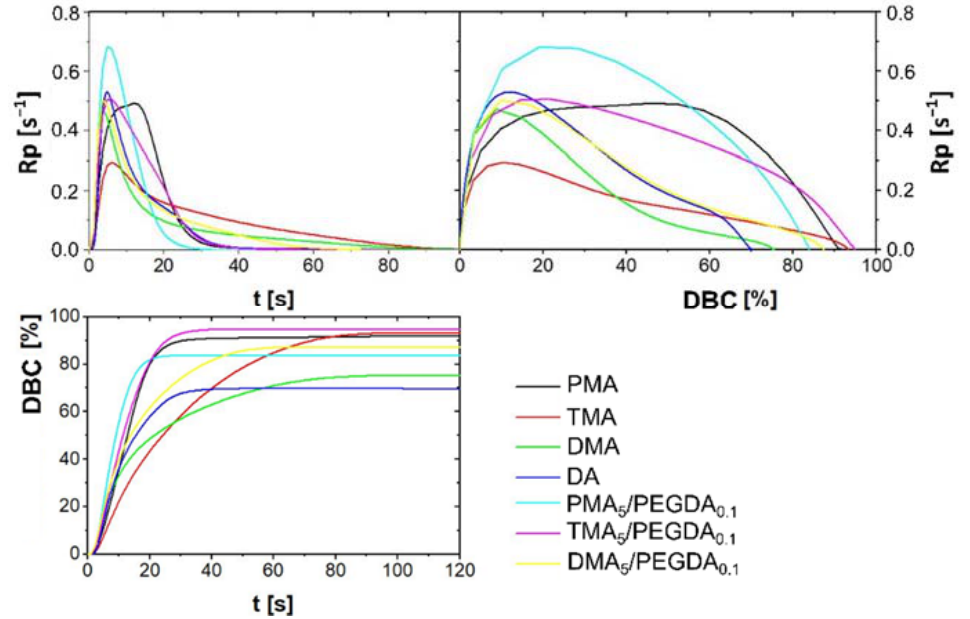
Figure 5. Photo-DSC of dopamine-modified acrylamides and HEAA/PEGDA to copolymers. Table 2. Results of photo-DSC and tensile shear test: Rp max (maximum photo-curing rate), t max : (time to reach Rp max ), Δ H max (maximum generated photo-curing heat), DBC max (maximum double bond conversion), F max (maximum force at break).